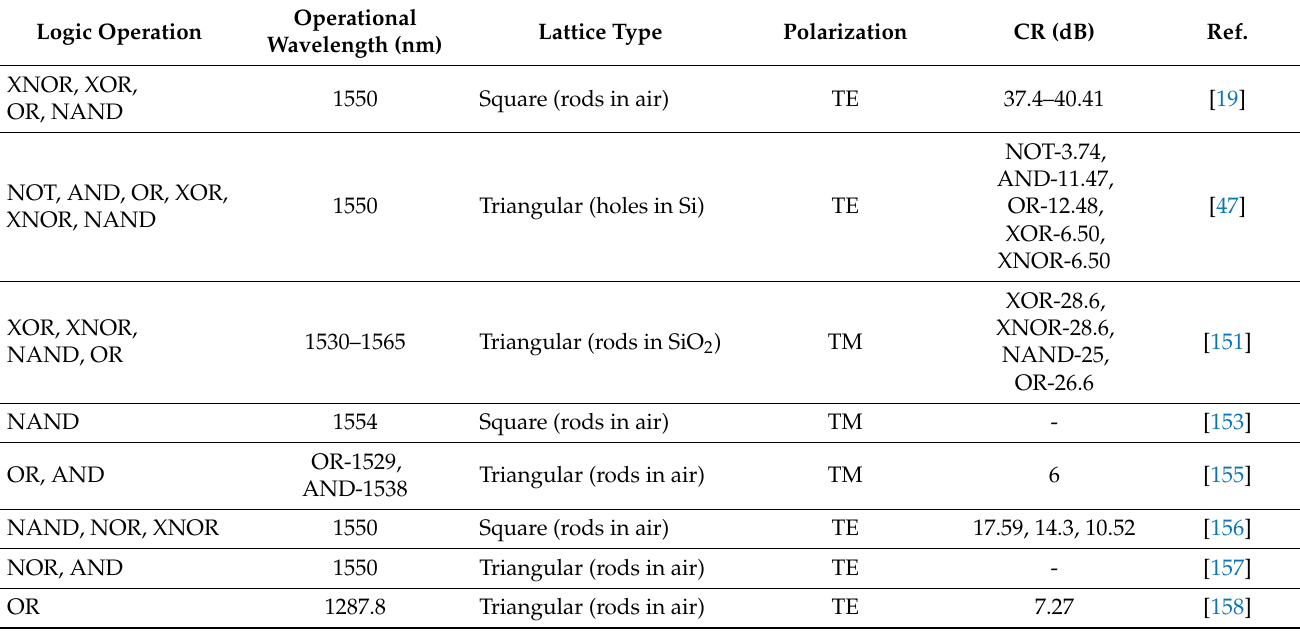
Table 2. Device performance of different types of PBG-based